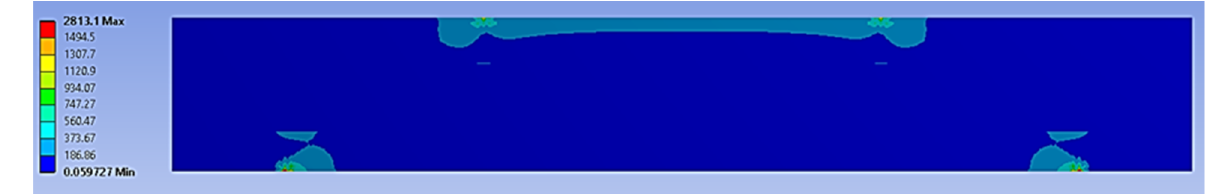
Figure 3. Example of stress distribution under the four-point bending simulation.